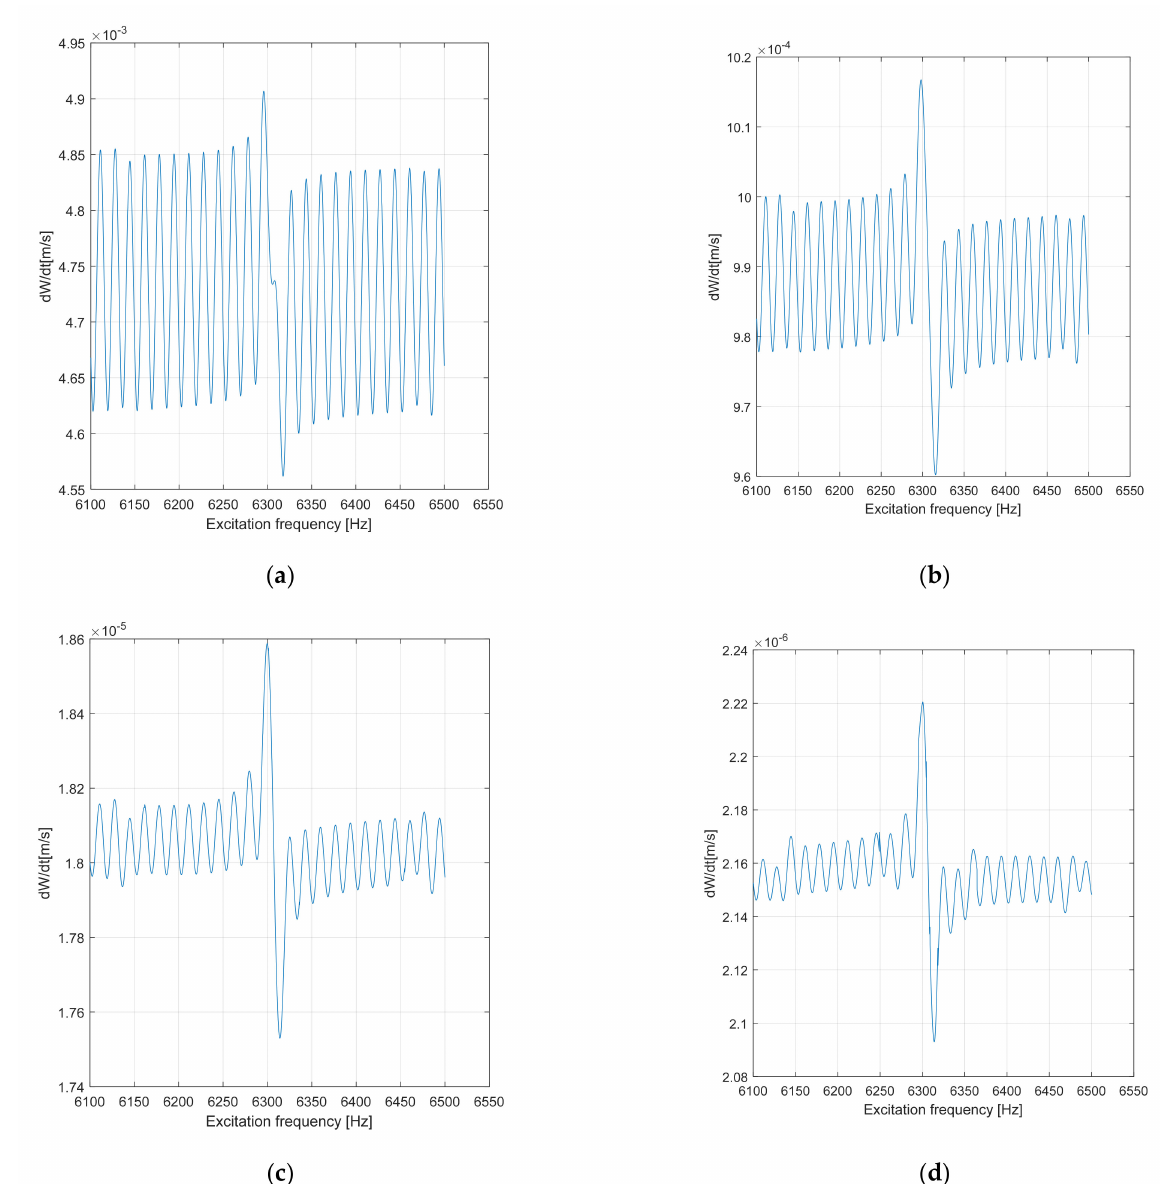
Figure 25. Nonstationary parametric velocity amplitude spectrum dW where µ = 0.754 × 10 − 4 . ( a ) ζ = 0.0016. ( b ) ζ = 0.0036. ( c ) ζ = 0.0076. ( d ) ζ = 0.0096. Here, m = 1.4 × 10 − 5